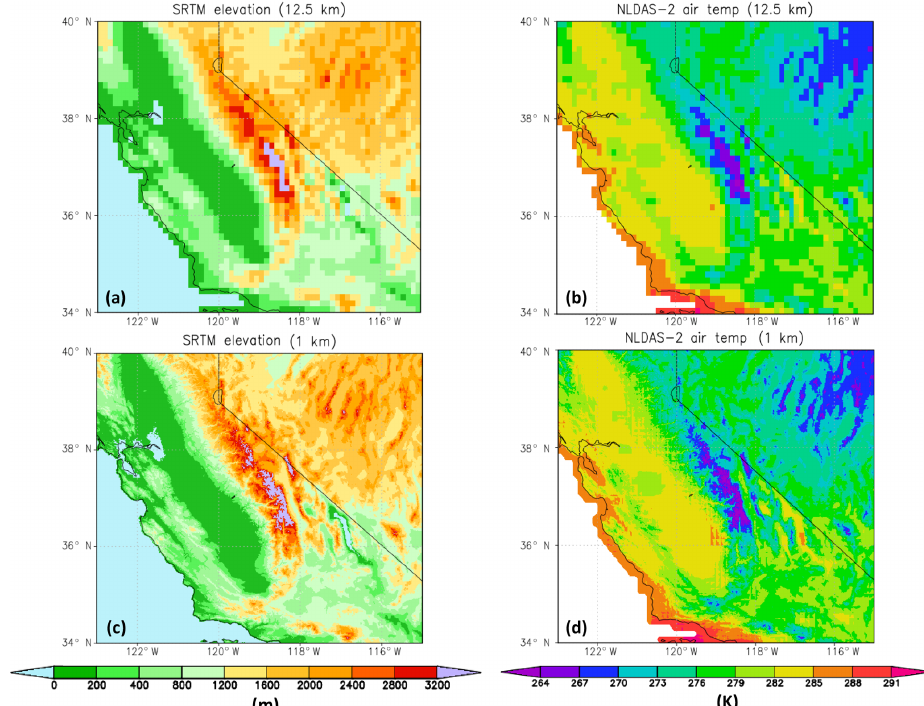
Figure 7. Examples of LDT-processed SRTM elevation parameter (in meters) at both (a) 12.5km and (c) 1km resolutions. (b) NLDAS-2 air temperature forcing field at its native 12.5km resolution on 1 April 2005 (18:00Z). (d) The 1km resolution SRTM elevation field was then used to “topographically downscale” the NLDAS-2 air temperature (in units of K) using the lapse-rate correction approach for the finer-detailed 1km air temperature field, as shown in plot (d)